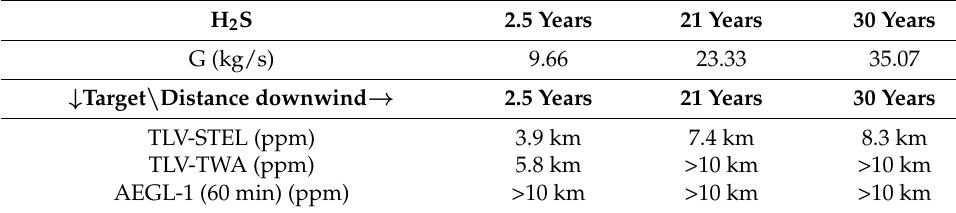
Table 8. H 2 S dispersion calculations using the Britter–McQuaid model.